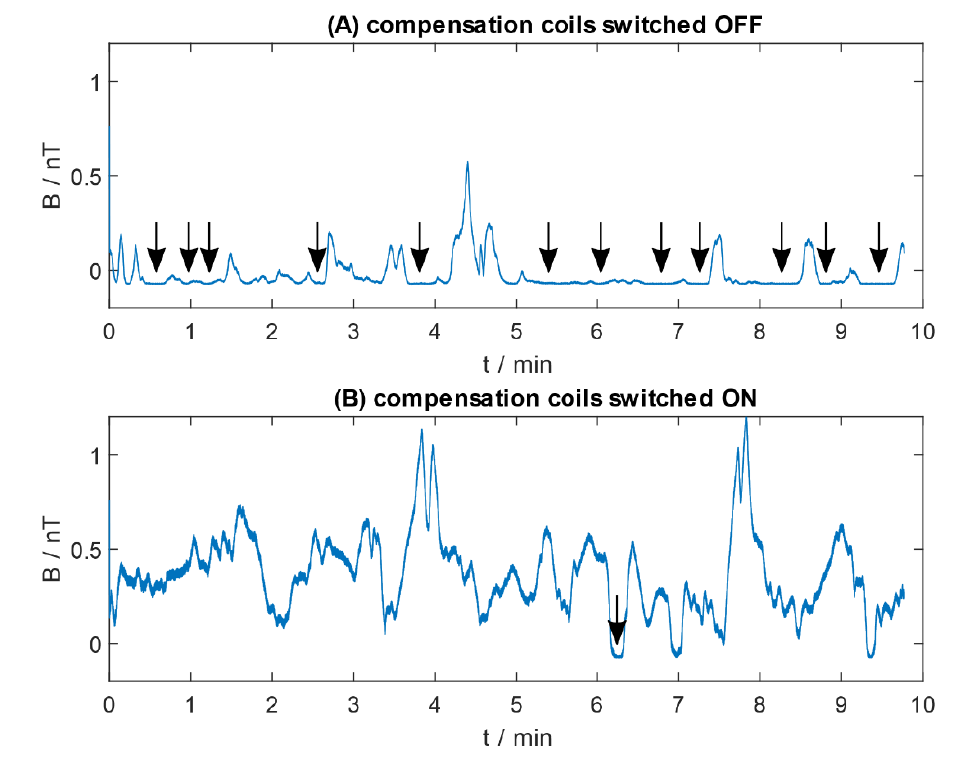
Figure 6. Residual magnetic field measured with QuSpin zero field magnetometer inside two-layer magnetically shielded room with the additional compensation coils: ( A ) switched off; ( B ) switched on. Arrows indicate the areas of signal saturation.